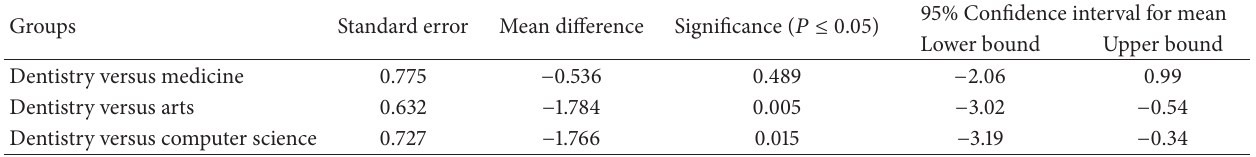
Table 3: Post Hoc test of the variance in mean anxiety scores between dental students and other study fields.